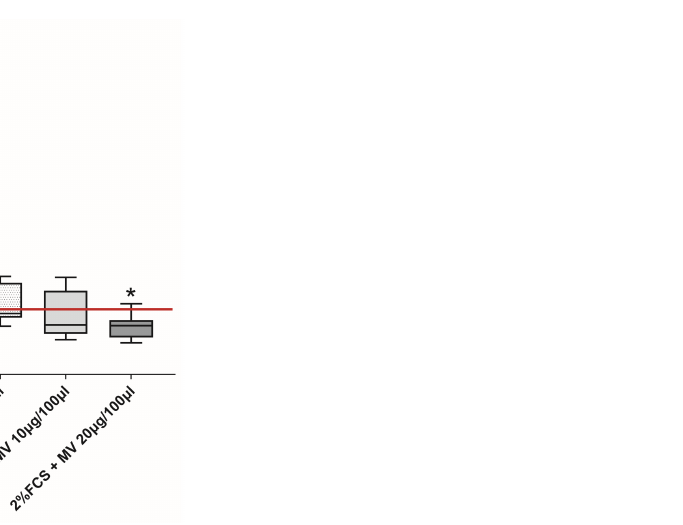
Figure 4. JEG-3 cells proliferate in the presence of MVs (n = 3). 2% FCS: baseline number of cells in the presence of medium supplemented with 2% FCS (marked with horizontal red line). 10% FCS: the number of cells in the presence of medium supplemented with 10% FCS. MV 2 µ g/100 µ L, 10 µ g/100 µ L, 20 µ g/100 µ L: the number of cells in the presence of MVs of NK-92 cells at protein con- centration per 100 µ L of medium with 2% FCS added (2, 10, 20 µ g/100 µ L, respectively). Significance of differences from baseline: * p < 0.05; *** p < 0.001.